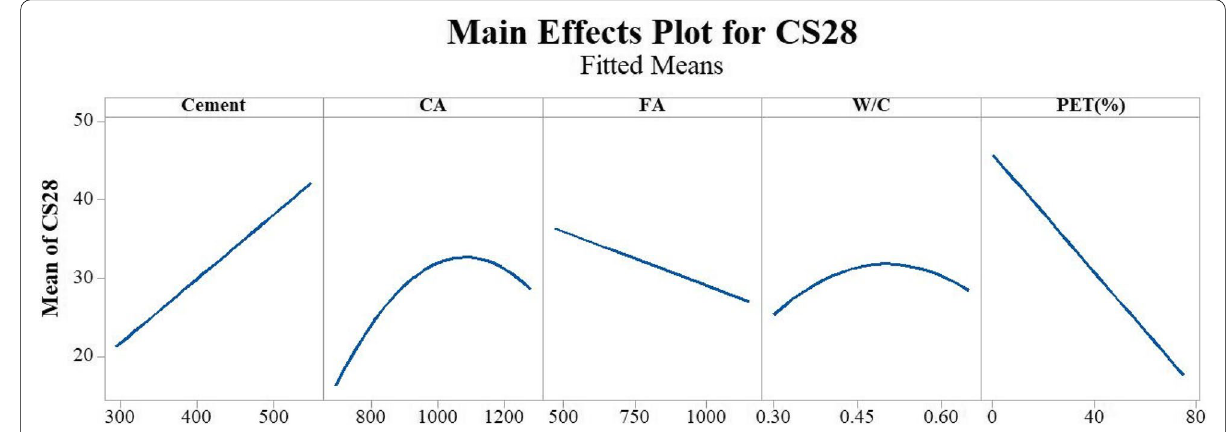
Fig. 7 Main effect plot of PET-FA expression